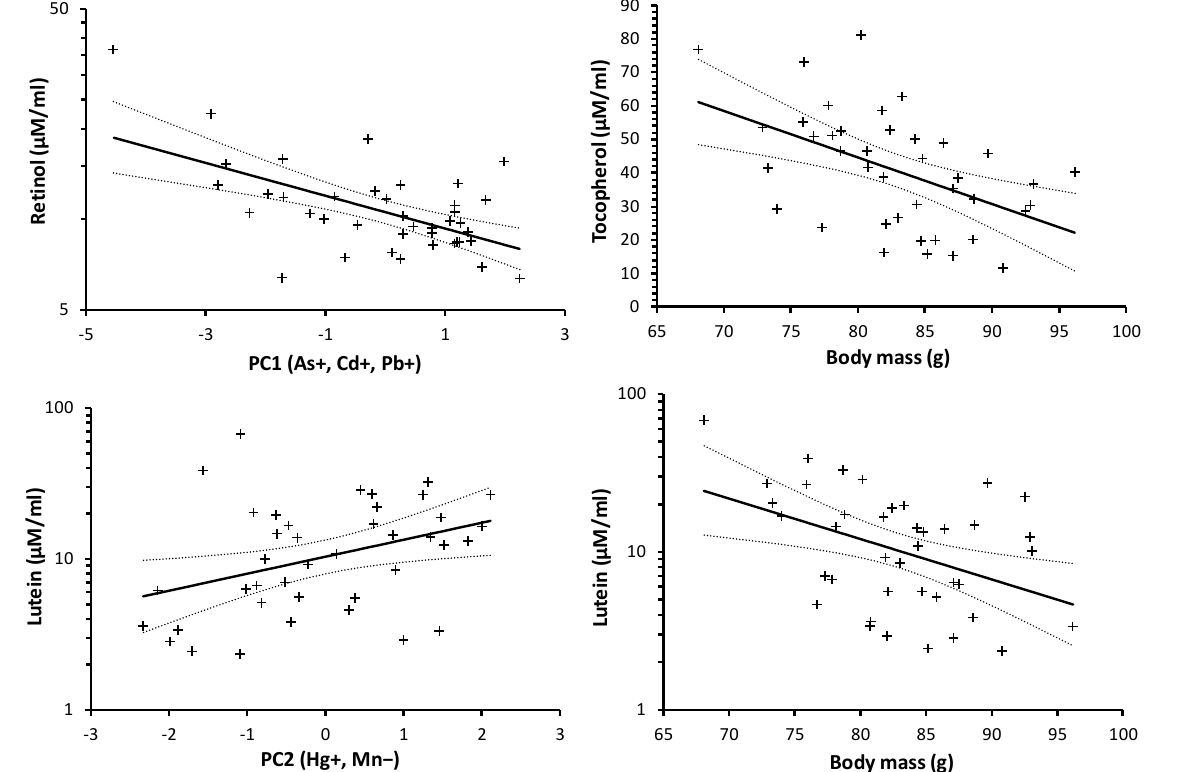
Figure 2. Biochemical markers in the plasma of Turdus merula , relative to the body mass and 1st and 2nd principal components (PC1 and PC2), describing the levels of toxic metals in blood (directions for the main factor loadings are shown in parentheses). Prediction line and 95% confidence limits come from the models of Table 3 (log-transformed values transformed back to the original scale). Plus signs denote the original data points.